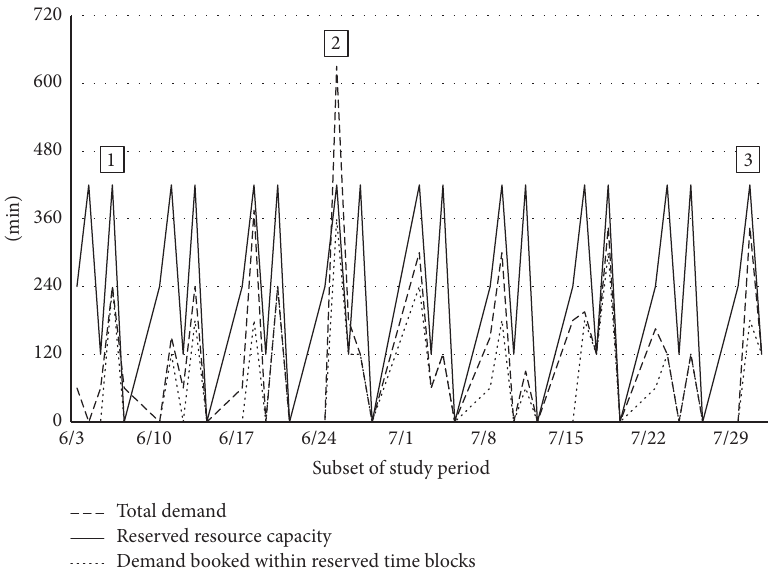
Figure 3: Subspecialty demand versus reserved resource capacity. Label 1: total subspecialty demand less than reserved capacity. Label 2: total subspecialty demand greater than reserved capacity. Label 3: subspecialty demand booked outside of reserved